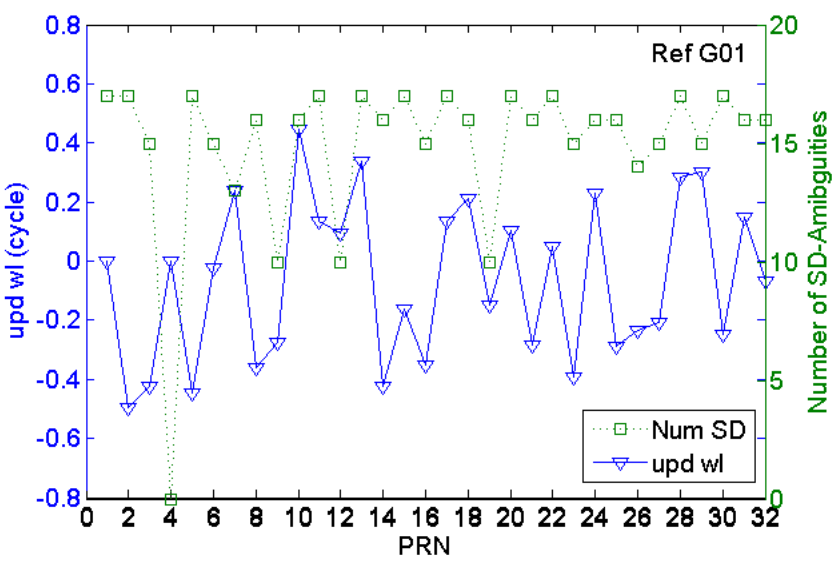
Figure 3. The fractional values of the wide lane ambiguity of G06 (reference satellite G02) at different stations.